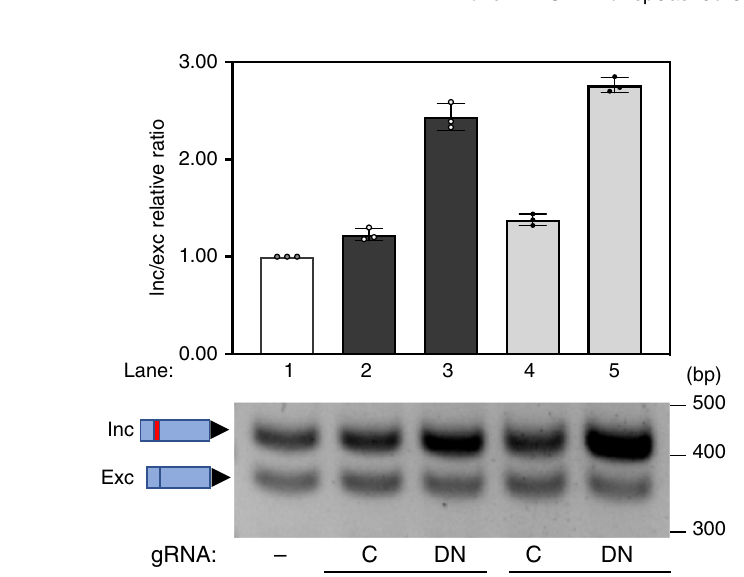
cycles. The primer sequences are provided in Supplementary Table 2. PCR pro- ducts were then analyzed on a 3% agarose gel. Quantitative RT-PCR . Quantitative RT-PCR reactions were performed using a LightCycler ® 480 instrument (Roche) and the ampli fi cations were done using the SYBR Green PCR Master Mix (Roche). Biological and technical replicate reactions were performed using 3 μ L of diluted cDNA in a 10 μ L reaction. All primer sequences used are provided in Supplementary Table 2. The relative ratio of inclusion/exclusion isoform was calculated using the ΔΔ Ct method and presented as a fold change compared with WT cells. RNA-seq and data analysis . Illumina Hiseq 2×150bp sequencing was performed by GENEWIZ. PolyA selection was applied for mRNA species in library preparation. FASTQ raw sequence fi les were quality checked with FASTQC version 0.11.5 41 . Low quality reads and adapter sequences were trimmed by Trimmomatic version 0.33 42 . Due to the length requirement of the downstream multivariate analysis of transcript splicing (rMATS) 43 , reads were processed to match the same length of 135bp based on the QC report. Shorter reads were discarded and longer reads were trimmed to remove the poor quality 3 ′ end. Mapping was performed by STAR aligner version 2.5.3 to the human genome (USCS RefSeq hg38 annotation) 44 . We then identify